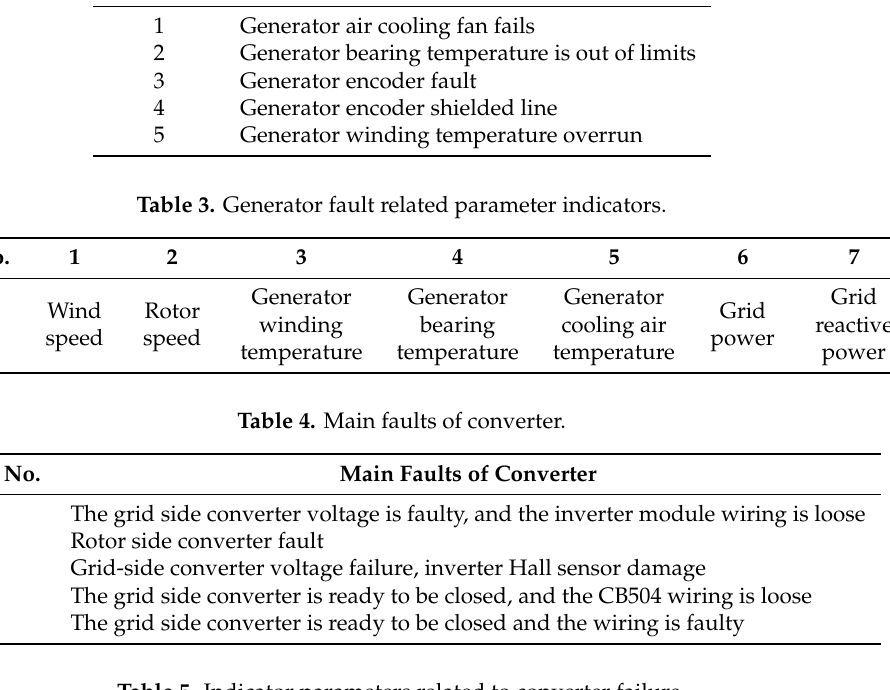
Table 5. Indicator parameters related to converter